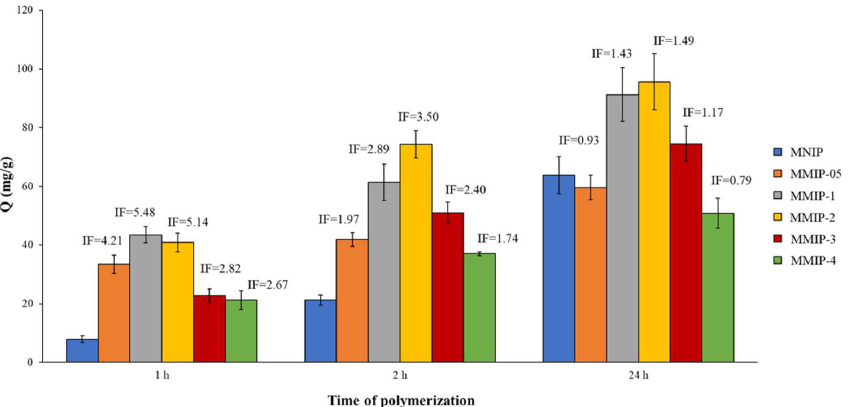
Figure 3. Evaluation of the binding capacity and imprinting factors (IFs) of the magnetic molecularly imprinted polymers/magnetic non−imprinted polymers (MMIPs/MNIPs) prepared with different amounts of SARS−CoV−2 peptide and different polymerization times.